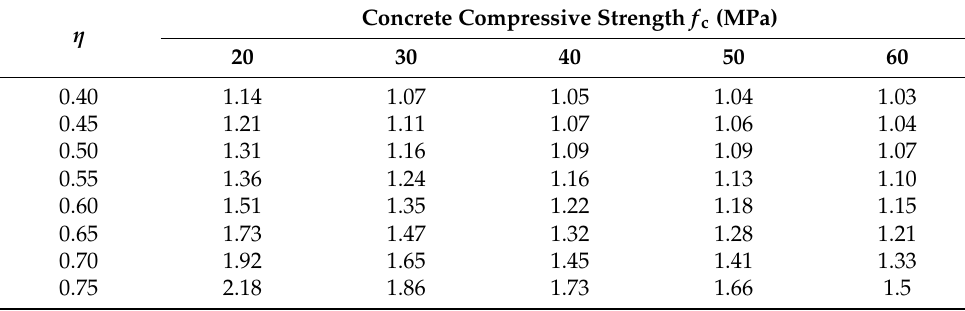
Table 2. Mean value of creep amplification